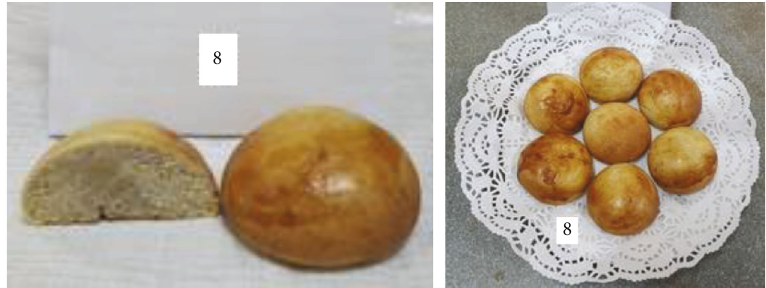
Figure 9: Sample no. 8 made from 15% chickpea and 10% mung fl our with